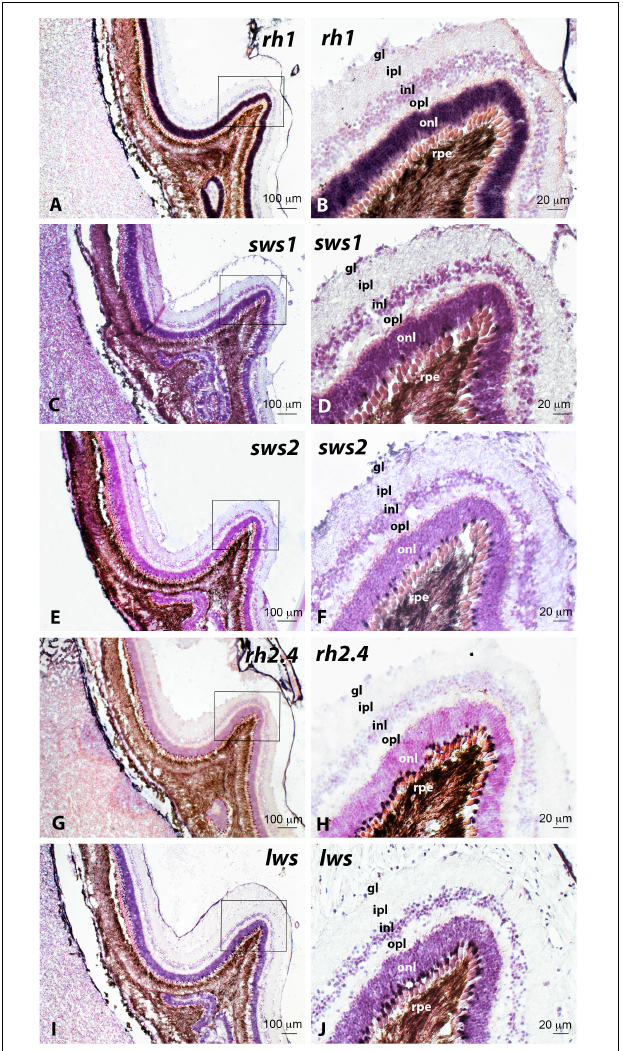
FIGURE 12 | Localisation of rod ( rh1 ; A,B ), ultraviolet cone ( sws1 ; C,D ), blue cone ( sws2 ; E,F ), green cone ( rh2.4 ; G,H ) and red cone ( lws ; I,J ) opsin-expressing cells in serial haematoxylin-eosin stained sections of the retina of adult Senegalese sole specimens revealed by in situ hybridisation. All the photomicrographs represent antisense sections. Squares in panels (A,C,E,G,I) mark the areas magnified in photomicrographs (B,D,F,H,J) , respectively. Note the presence of abundant rh1 -positive cells in the outer nuclear layer (onl, A,B ), important amount of rh2.4- (G,H) , and lws- (I,J) expressing cells and lower number of sws1- (C,D) and sws2- (E,F) expressing cells in the retina of adult specimens. For other abbreviations, see the legend in Figure 2 . Scale bars represent 20 µ m in panels (B,D,F,H,J) ; and 100 µ m in panels (A,C,E,G,I) .